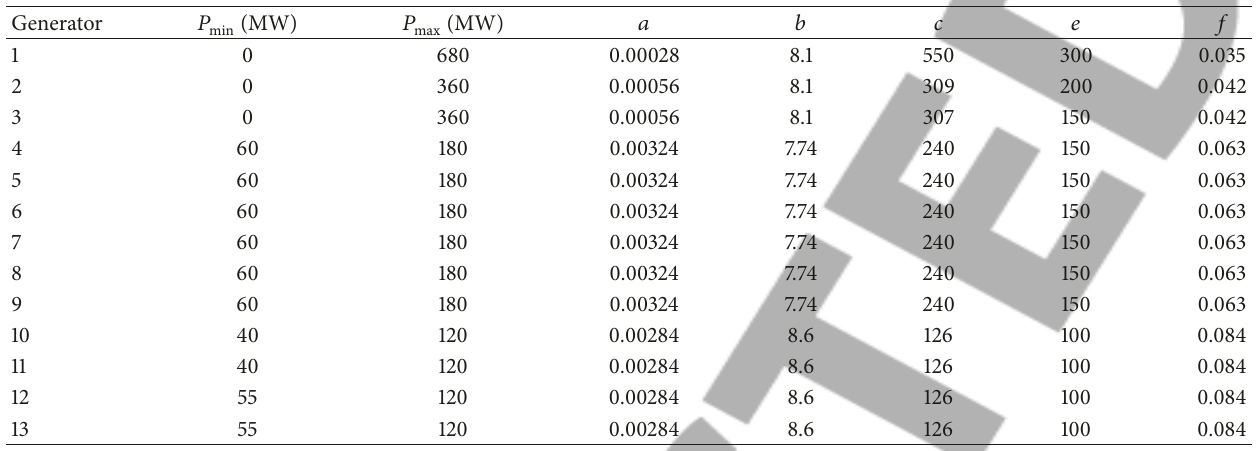
Table 6: Units data for 13 thermal units’ system.